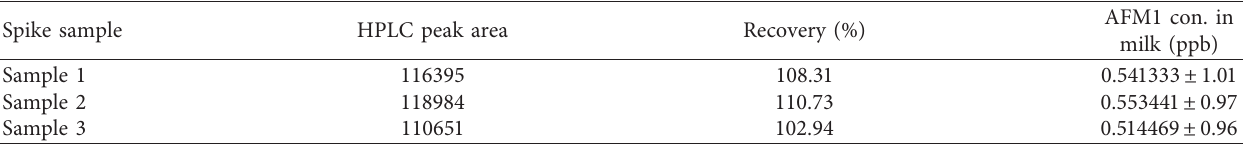
Table 1: Validation of detection protocol through recovery of known amount of mycotoxins in AFM1-free milk. AFM1-free samples were mixed with a known amount of AFM1 standard and analysed by HPLC.